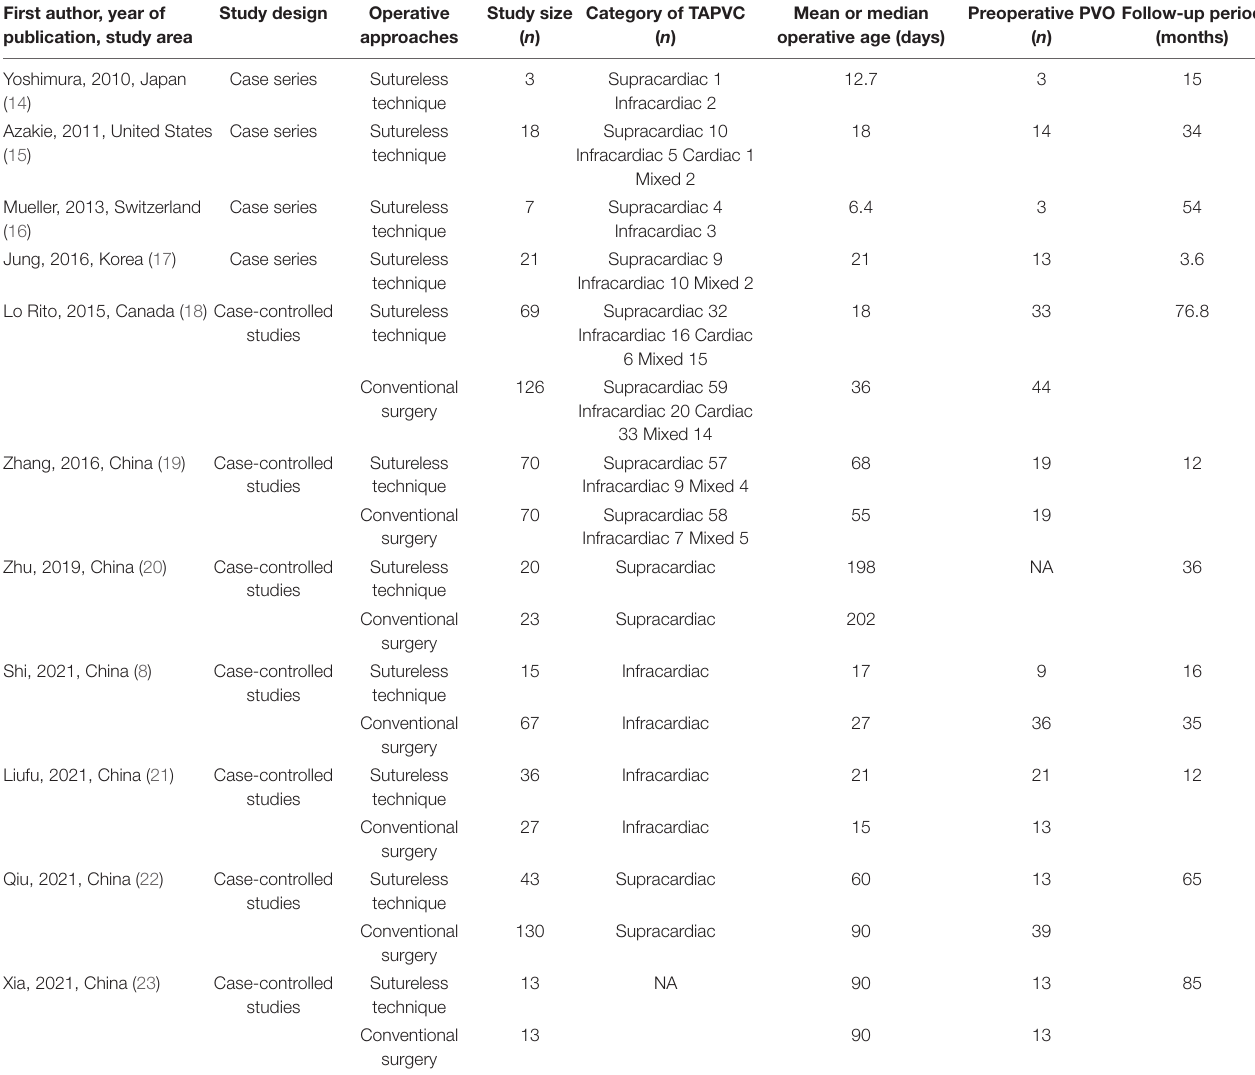
TABLE 1 | Baseline characteristics of the included